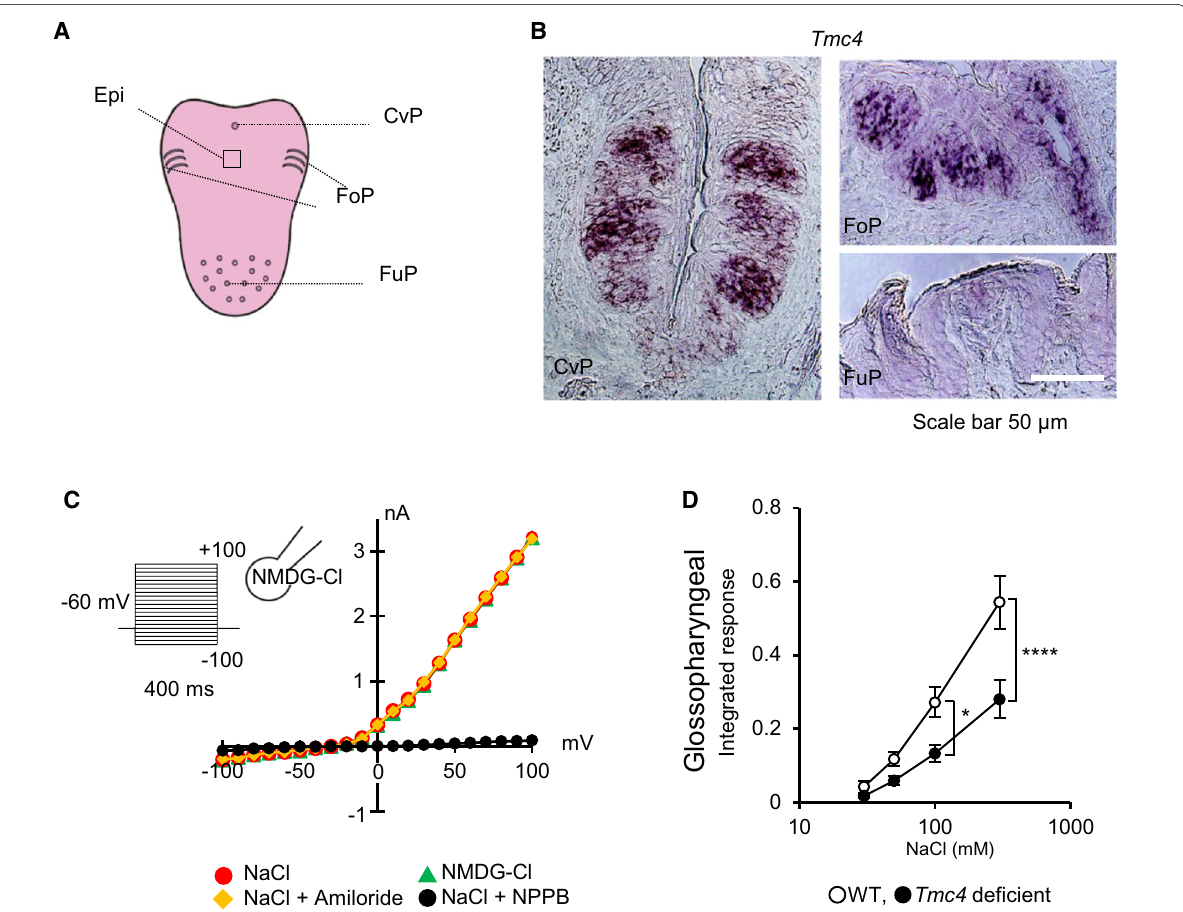
Fig. 1 TMC4 is a novel voltage-dependent chloride channel that is specifically expressed in the posterior part of the tongue and is responsible for the salt response of the glossopharyngeal nerve. A Location of the circumvallate papillae (CvP), foliate papillae (FoP), and fungiform papillae (FuP) on a mouse tongue. Surrounding epithelia (Epi) means to the epithelia of the tongue that does not contain taste papillae. B In situ hybridization of Tmc4 mRNA is specifically detected in the CvP and FoP, but barely detected in the FuP. C Representative I-V relationship of the currents using step pulses (the holding potential was -60 mV, and stimulated from 100 to 100 mV [∆10 mV] for 400 ms) under different bath solutions. The mouse − + TMC4-mediated outward current is not affected by the bath application of N -methyl-D-glucamine (NMDG)-Cl, NaCl, or amiloride (epithelial sodium channel inhibitor), but is significantly reduced by the anion channel inhibitor, 5-nitro-2-(3-phenylpropylamino) benzoic acid (NPPB). D) Integral glossopharyngeal nerve response of wild-type (WT) or Tmc4 -deficient mice to NaCl solutions (30, 50, 100, and 300 mM). The asterisks ( * , **** )